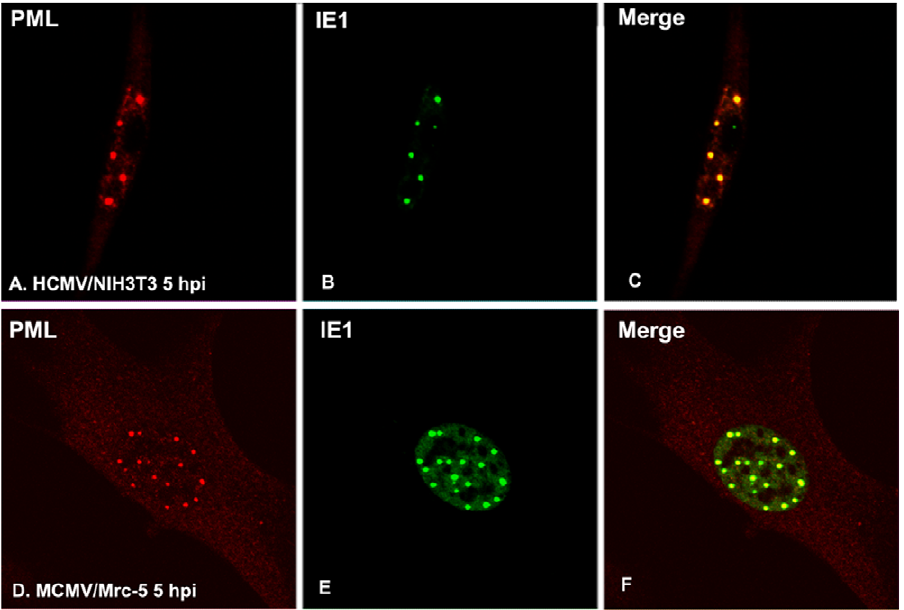
Figure 1. Immunofluorescent assay to show IE1 and ND10 in CMV cross-species infection. A–C : After HCMV infection in NIH3T3 cells for 5 hour, cells were stained with anti-PML antibody (rabbit) to show ND10 (in red) (A); anti-IE1 antibody (mouse) was used to show IE1 (in green) (B); the merged picture is shown in C. D–F : After MCMV infection in Mrc-5 cells for 5 hour, cells were stained with anti-PML antibody (Rabbit) to show ND10 (in red) (D); anti-IE1 antibody (mouse) was used to show IE1 (in green) (E); the merged picture is shown in F. doi:10.1371/journal.pone.0019187.g001 PLoS ONE |